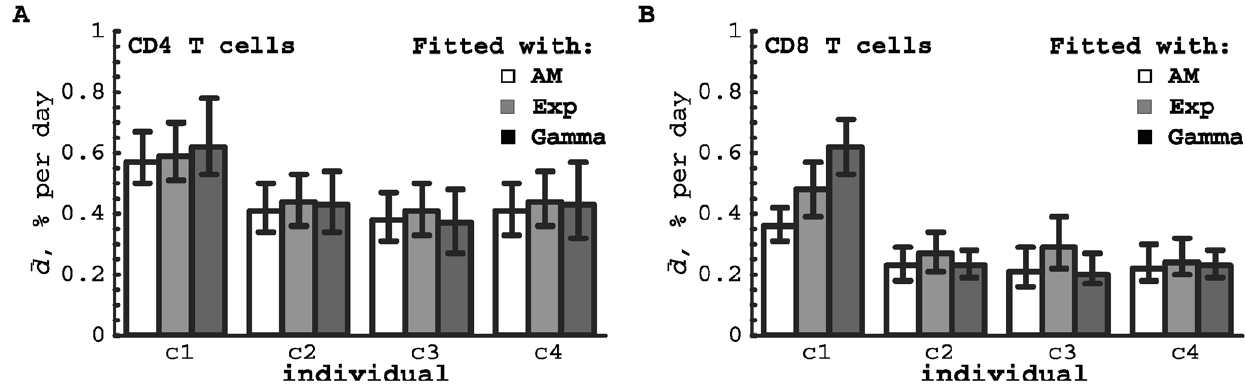
Figure 7. Estimates of the average turnover rates of human T cells. Data on deuterium labeling of CD4 + (panel A) and CD8 + (panel B) T cells in four healthy humans were fitted with three different models: the Asymptote model (empty bars), the Exponential model (gray bars), in which a fraction a of the cells have exponentially-distributed turnover rates, and the Gamma model (black bars) with gamma-distributed turnover rates. Best fits of the data are shown in Figure 6, and estimates of all parameters of the models are shown in Tables S2 and S3. Confidence intervals were obtained by bootstrapping the residuals with 1000 simulations. Note that all models deliver very similar estimates for the average turnover rate (cid:1) dd , with the exception of the estimated CD8 + T-cell turnover rates in individual c1 which are highly